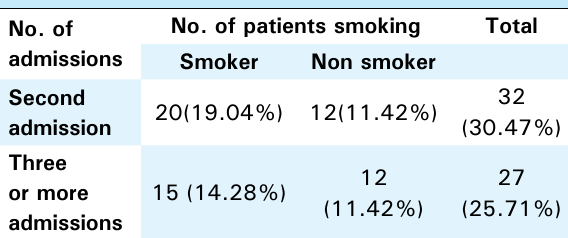
table 3. Incidence of